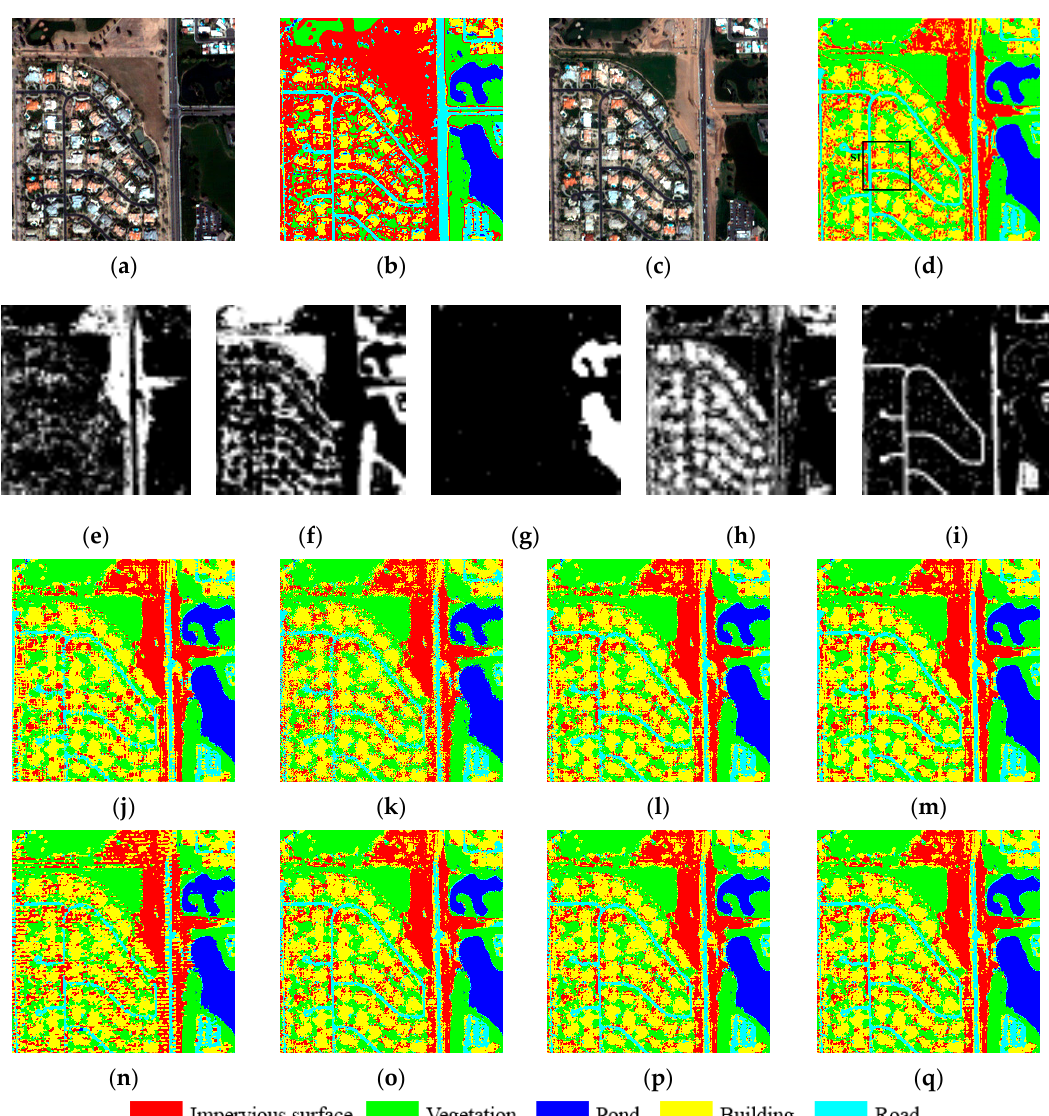
Note: The highest accuracies in the table are marked with bold.